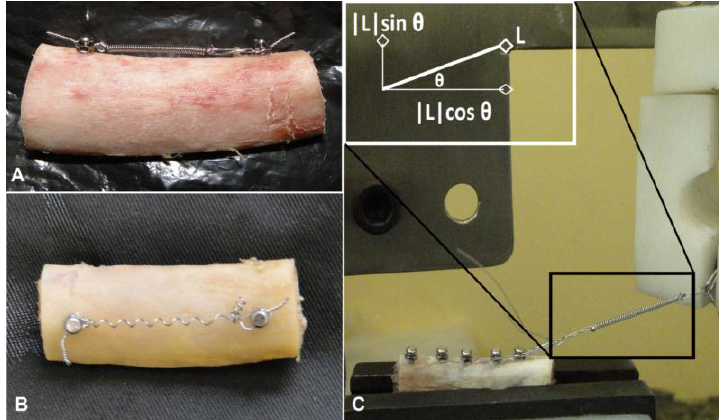
Figure 1. Temporary screws design. ( A ) Screws were tapered with a minor diameter of 1.5 mm and a length of 6 mm. ( B ) Threads had self-drilling ability.